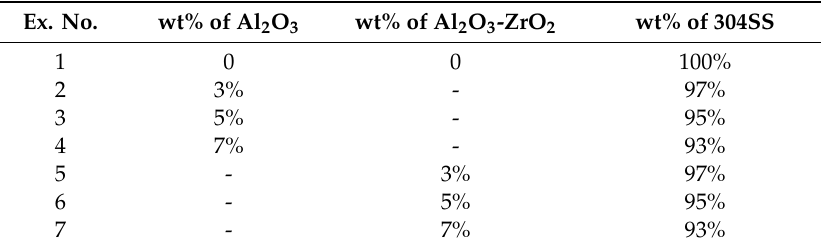
Figure 1. Selective laser melting (SLM) system: ( a ) Experimental setup; ( b ) Schematic illustration. The laser power and scan speed were 200 W and 732 mm / s, respectively. For comprehensive comparison, various weight percentages of Al 2 O 3 and the eutectic mixture of Al 2 O 3 -ZrO 2 were employed in the reinforcing experiments, as shown in Table 1. Table 1. Numerical and experimental runs.